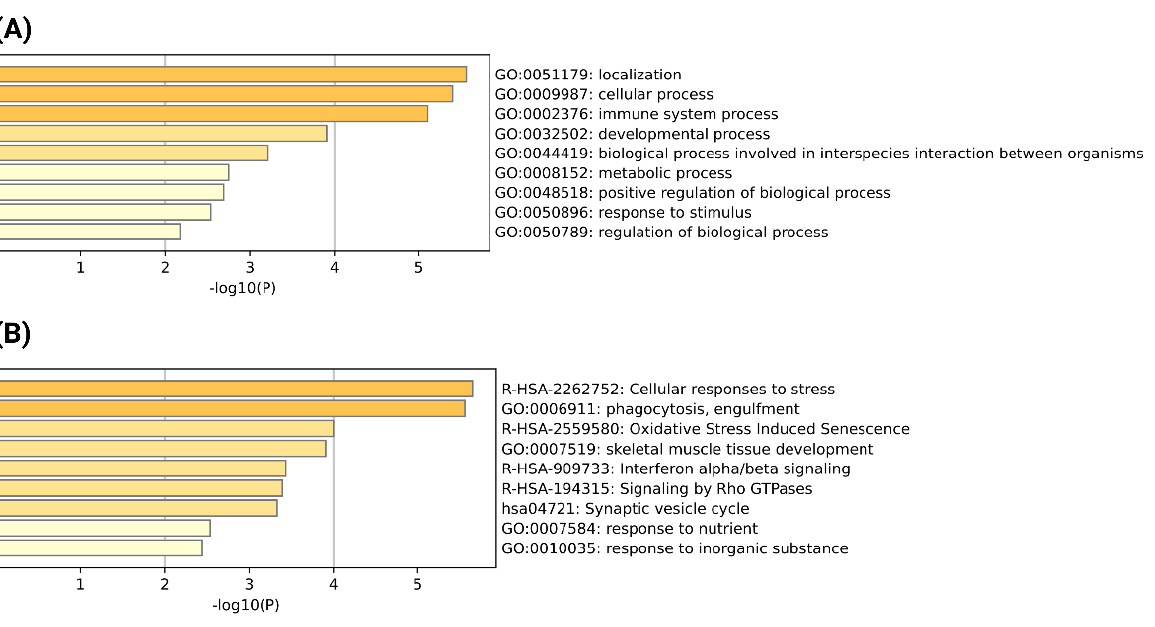
Figure 2. ( A ) GO biological process enrichment analysis of the parental genes of severe COVID-19 specific recurrent chimeric transcripts; ( B ) Top-most enriched processes and pathways of the parental genes of severe COVID-19 specific recurrent chimeric transcripts detected by Metascape ( p -value cutoff < 0.05).